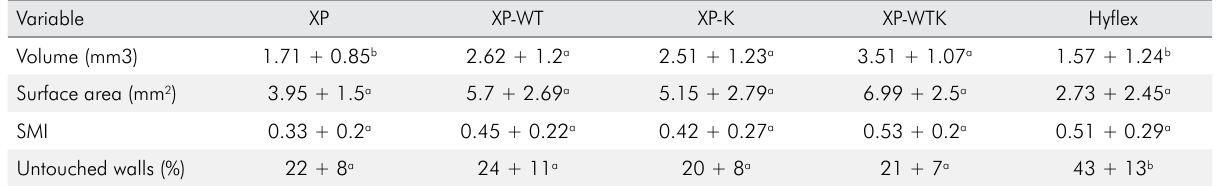
Table 2. Morphometric three-dimensional data (mean + standard deviation) values and percentage of untouched walls of root canals of mesial mandibular molars according to the root canal preparation protocols.